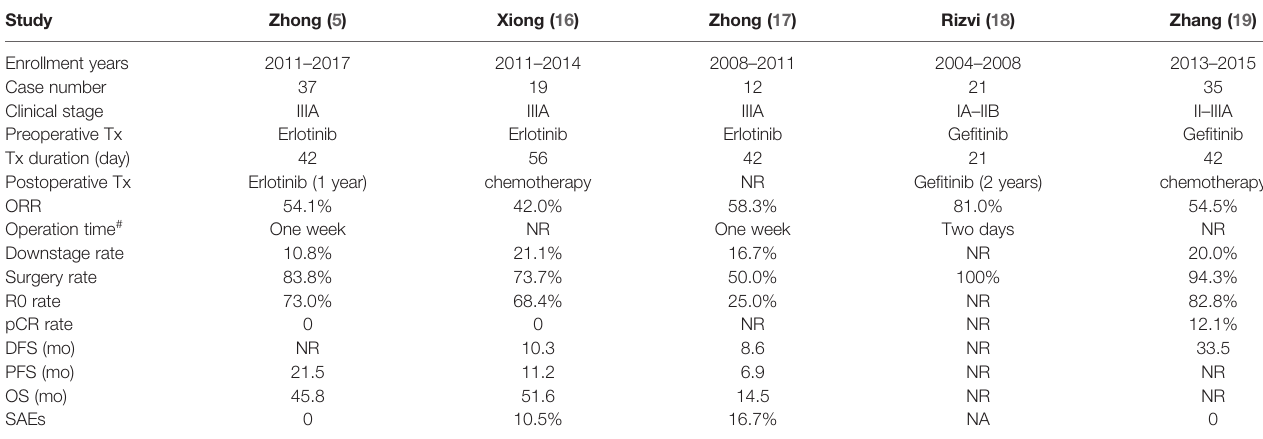
TABLE 1 | Characteristics of included